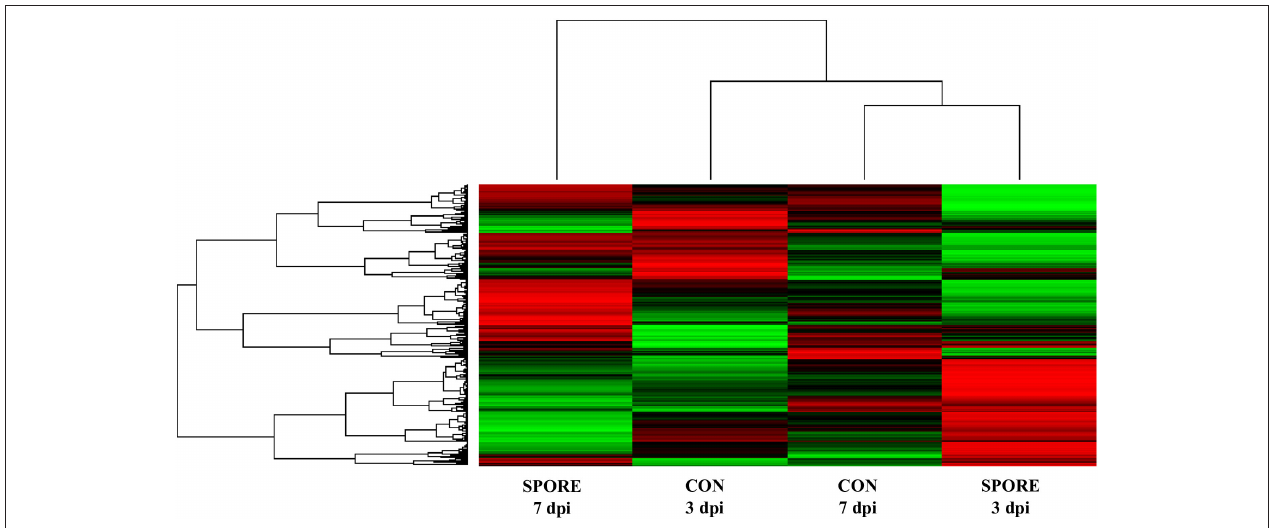
FIGURE 8 | Heatmap and clustering of kinome profiles. The raw kinome signal from the peptide array was input into the custom software package PIIKA 2. Red indicates relative increased phosphorylation, whereas green indicates relative decreased phosphorylation of each peptide on the